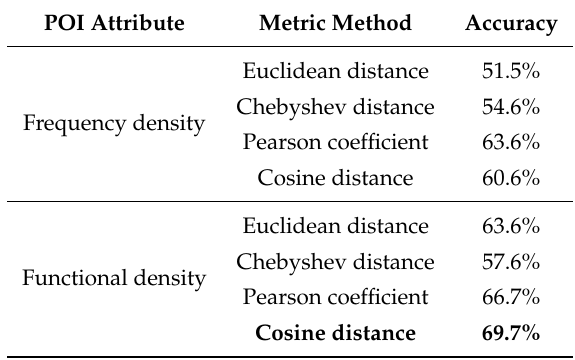
Table 4. The accuracy of single stage in different metric method based on POI